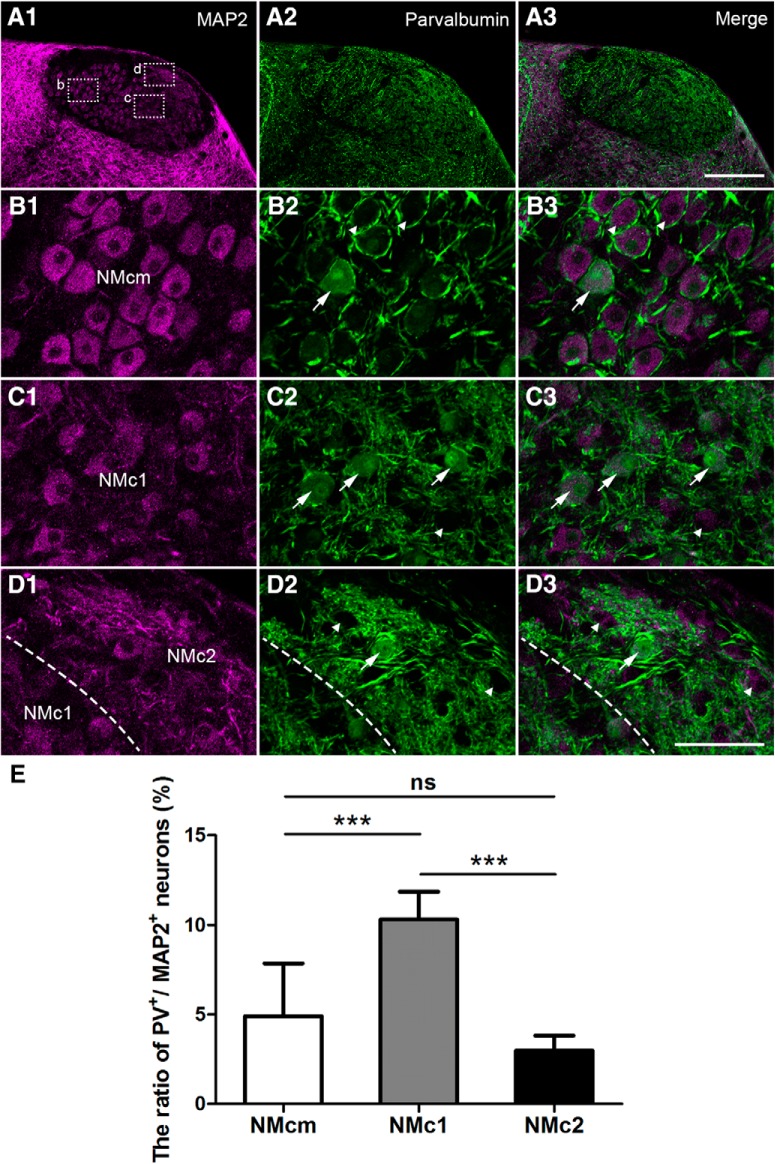
Differential expression of parvalbumin in the caudal NM. The left (A1, B1, C1, D1) and middle (A2, B2, C2, D2) columns are MAP2 and parvalbumin immunostaining, respectively. The right column (A3, B3, C3, D3) is the merged images. A, Low-magnification images were taken from a section at the level of Fig. 1G. B–D, High-magnification images of the boxes in A1. All images were collected with the same imaging parameters and processed in the same way. Arrows and arrowheads in B–D indicate labeled and unlabeled somata for parvalbumin. The border between NMc1 and NMc2 is indicated by dashed lines in D. E, Bar chart of the ratio of parvalbumin-expressing neurons in NMcm, NMc1, and NMc2. ***, P < 0.001; ns, not significant. Data are presented as mean ± SD. Abbreviations: see Fig. 1. Scale bars = 100 μm in A3 (applies to A1–A3) and 50 μm in D3 (applies to B1–D3).